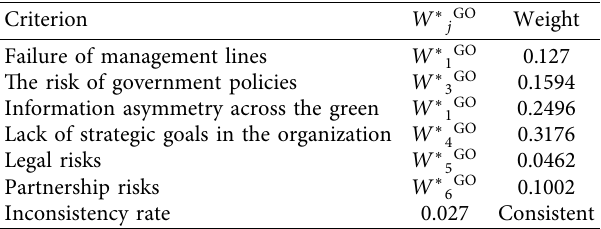
Table 12: Average weights of organizational and government risk